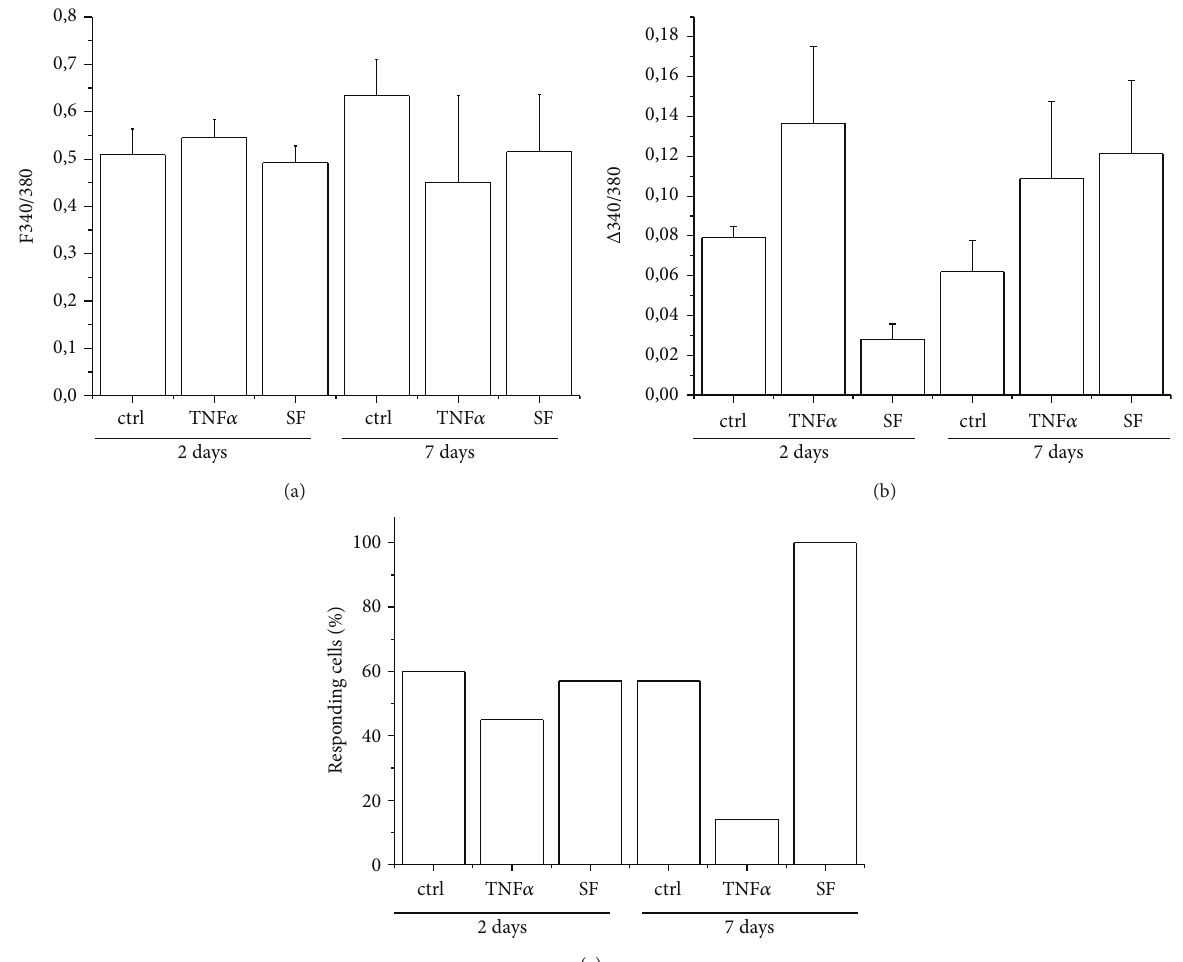
Figure 5: Effect of TNF 𝛼 and synovial fluid on intracellular calcium dynamics in ATP-challenged fibroblast-like synovial cells. (a) Quantitative evaluation of basal intracellular calcium levels in FLS exposed to either TNF 𝛼 or SF pool 1 for either 2 or 7 days. No significant changes in basal intracellular calcium dynamics in the different experimental conditions are observed. A drastic change in amplitude of response (b) and percentage of responding cells (c) to 1 mM ATP is observed between TNF 𝛼 and SF samples. In particular, TNF 𝛼 seems to have an acute effect at shorter times of exposure on the quantity of functional P2 receptor at the plasma membrane, while SF samples show an important change in responsiveness at longer times of